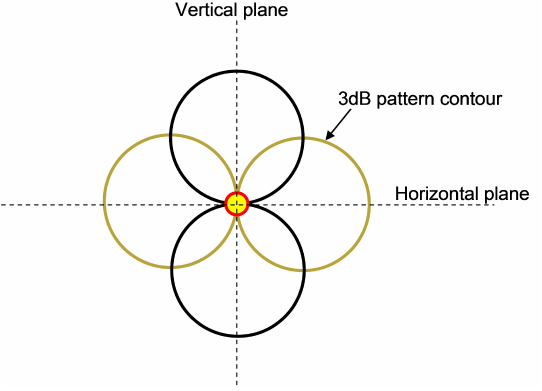
Figure 2. Radiometric seeker sensor 3 dB contours.